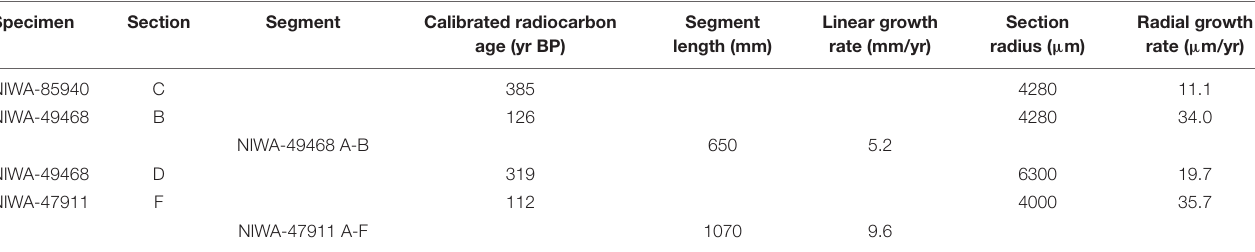
TABLE 4 | Bathypathes patula growth rate